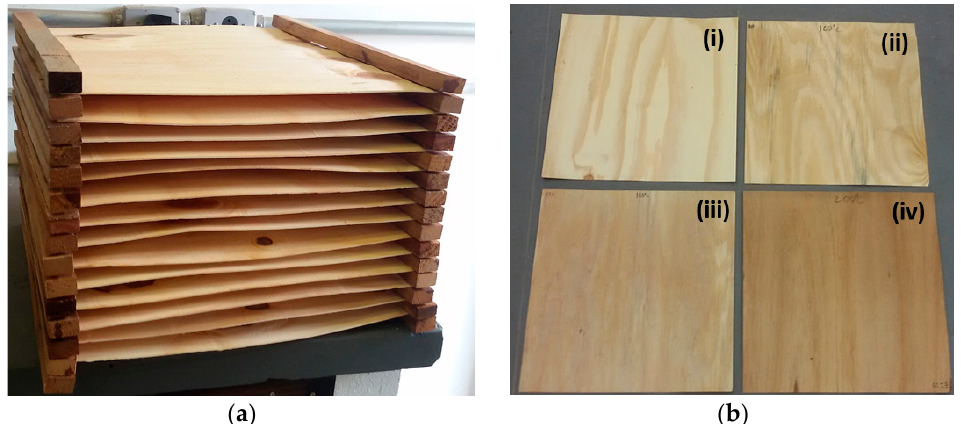
Figure 1. Heat treatment of the veneers. ( a ) Veneers stacking. ( b ) Heat-treated veneers: (i) no treatment, (ii) 160 °C, (iii) 180 °C and (iv) 200 °C.